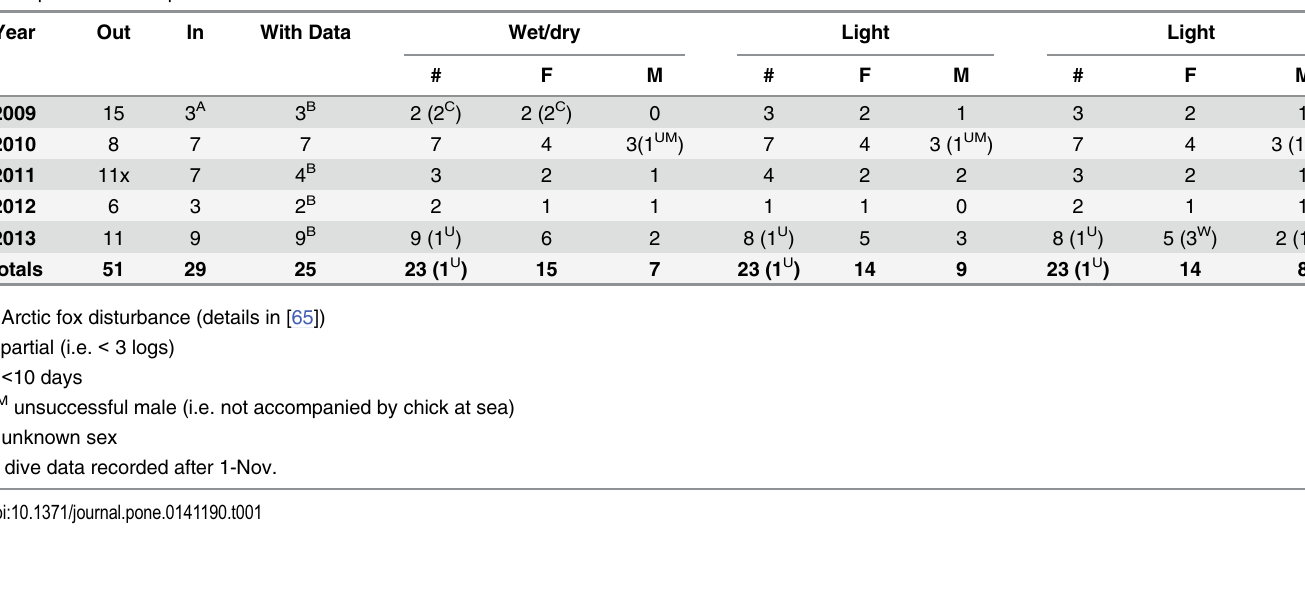
Table 1. Deployments (Out), retrievals (In) and data outcomes by site, year, sex and log type. Numbers refer to individuals. Letter superscripts explain discrepancies in sample